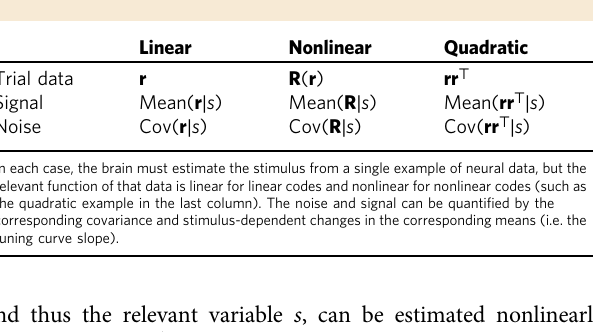
Table 1 Neural response properties relevant for linear and nonlinear